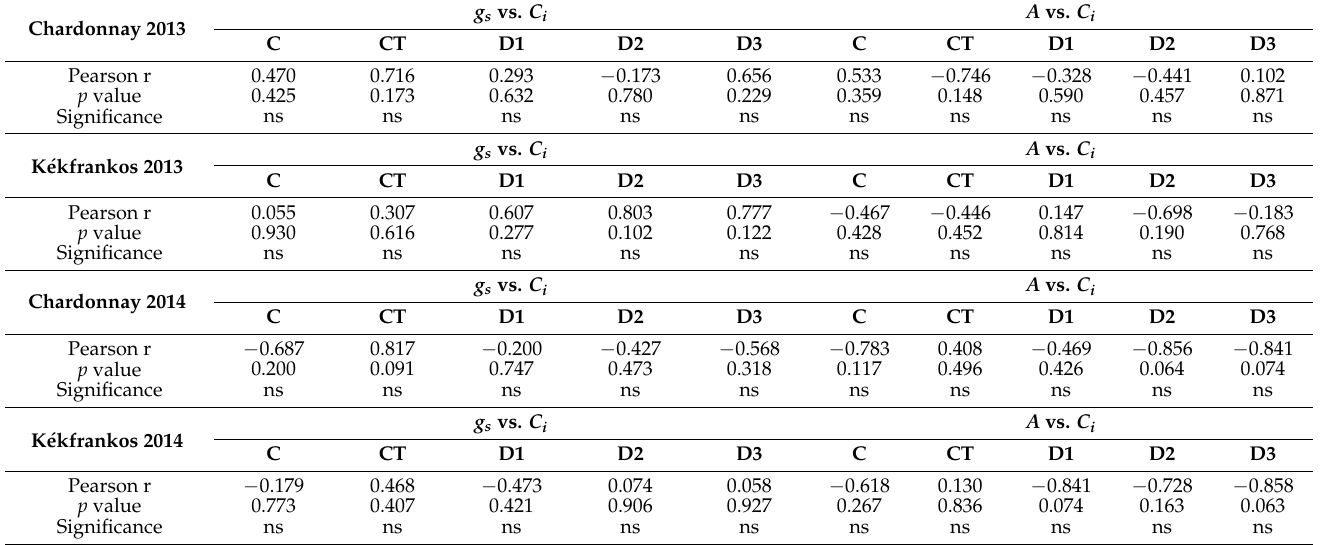
Table A2. Results of the correlation analysis between mean stomatal conductance ( g s ) and intercellular CO 2 concentration ( C i ) data, as well as mean leaf assimilation rate ( A ) and C i data in the case of each treatment, variety, and year, with 5-5 measurement dates/year. The "ns" defined as not significant